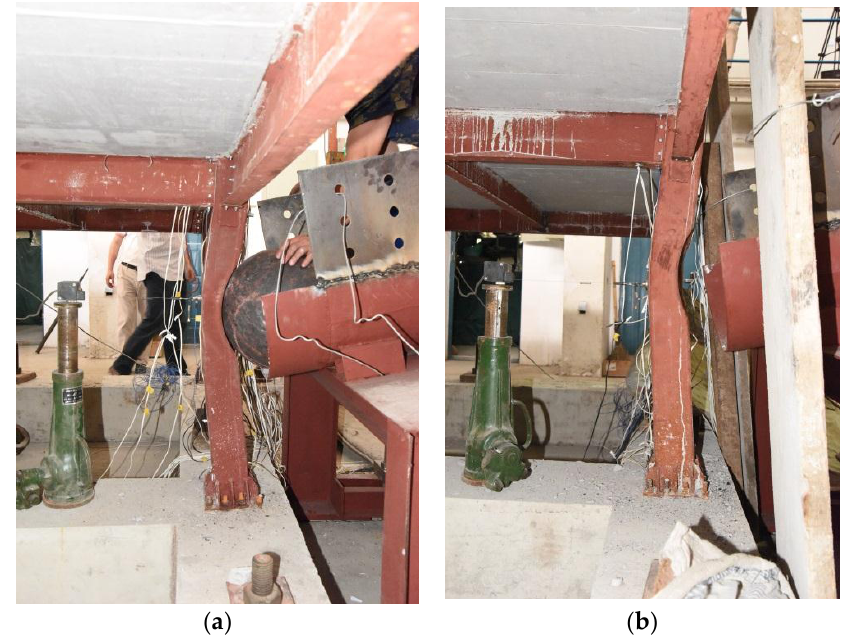
Figure 10. Strain curves at the top of first floor impacted column. ( a ) The maximum normal strain; and ( b ) the maximum shear strain of its side plate.